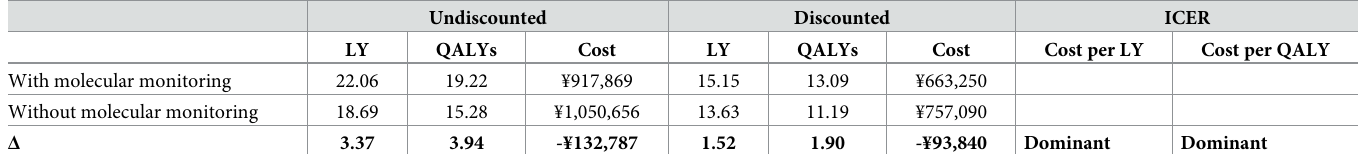
Table 3. Base case analysis